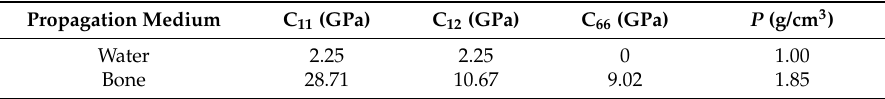
Figure 2. Particle velocity waveforms derived from two different numerical tools, Simsonic and k-Wave, for grid size 20 μm. The threshold for the detection of the FAS is also depicted. 3. Numerical Evaluation of Cortical Porosity Using Ultrasonic Techniques 3.1. Model Geometry In this section, we present the structural features of the computational models representing different cases of cortical porosity and pores’ sizes as well as different number and distributions of RL. The structural and material properties were derived from [14], in which the Haversian canals of normal size were differentiated from the RLs to distinguish healthy bones (with no or few RL) from degenerated ones. As can be seen in Figure 1, the cortical bone was modeled as a 2D plate (length 40 mm, width 4 mm) surrounded by water (upper surface 4 mm, lower surface 2 mm). Two sets of numerical simulations were performed in order to evaluate: (a) porosity changes from 0% to 16% covering the whole region of cortical bone (Series I_Po0-16), (b) the occurrence of a single or a cluster of RL in small propagation paths (Series II_RL). The selection of the porosities of Series I_Po0-16, and the sizes of the RL were based on previous studies investigating the interaction of ultrasound with cortical porosity [2,5,10,14]. However, it should be emphasized that the evaluation of cortical porosity depends on several parameters such as age, gender and region of interest [5]. The first set is presented in Figure 1, in which cortical bone was modeled both as a homogeneous and nonhomogeneous medium to account for the cases of: (a) intact bone (Figure 1a); (b) porosity 5% (Figure 1b); (c) porosity 10% (Figure 1c); and (d) porosity 16% (Figure 1d–f). In Table 2, we present the exact structural features concerning the porosity, number and dimensions of the normal and larger pores. For each microstructural scenario of Table 2, a total of three numerical models were established and the mean local FAS velocity values were calculated as well as the standard error.